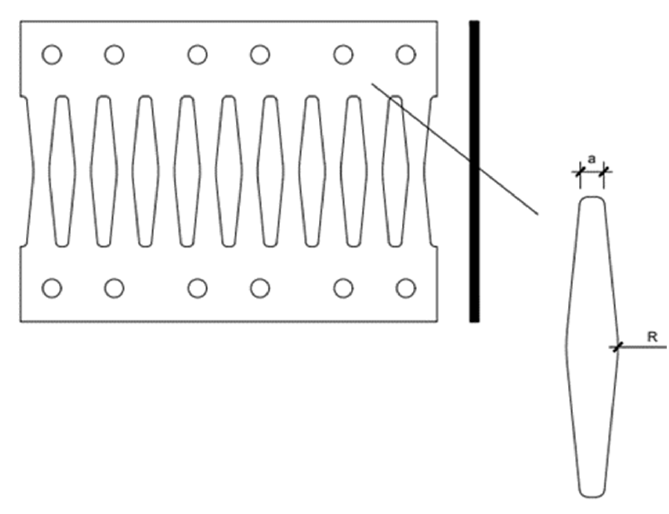
Figure 3. The curved metal damper and considered parameters for optimization.